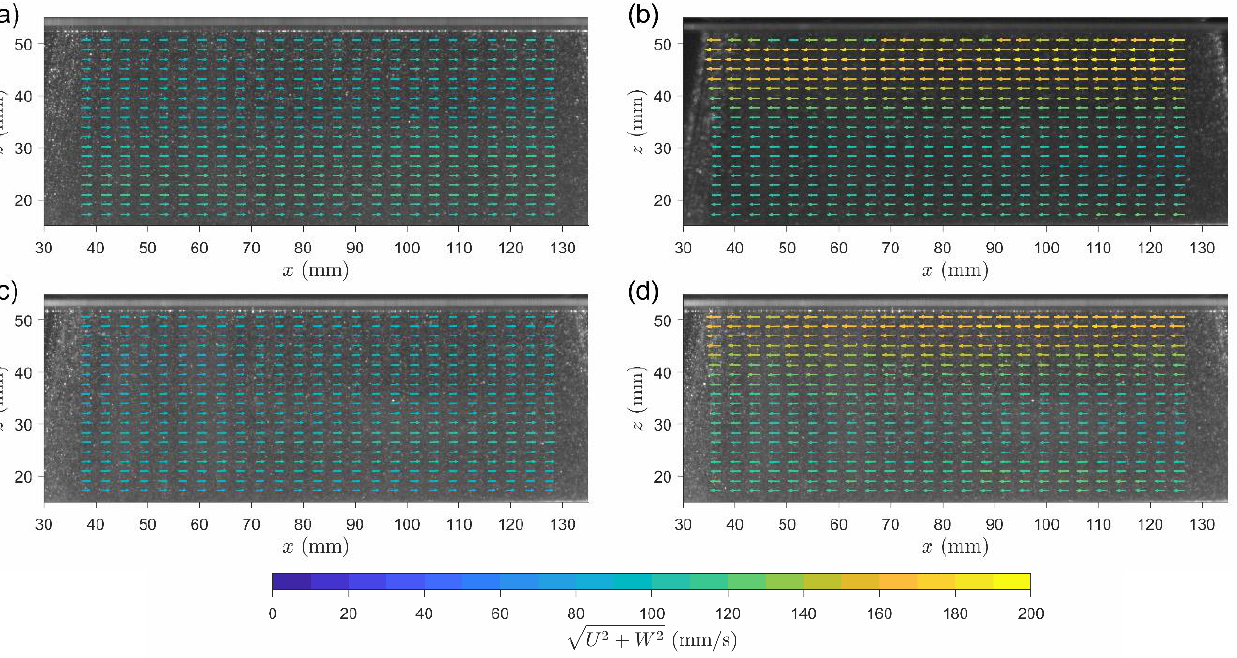
Figure 7. Time-averaged velocity maps determined by typical PIV analysis and the proposed algorithm. ( a ) case PIVR , ( b ) case PIVG , and result corresponding to the ( c ) 1st peak and ( d ) 2nd peak in case PIVB .